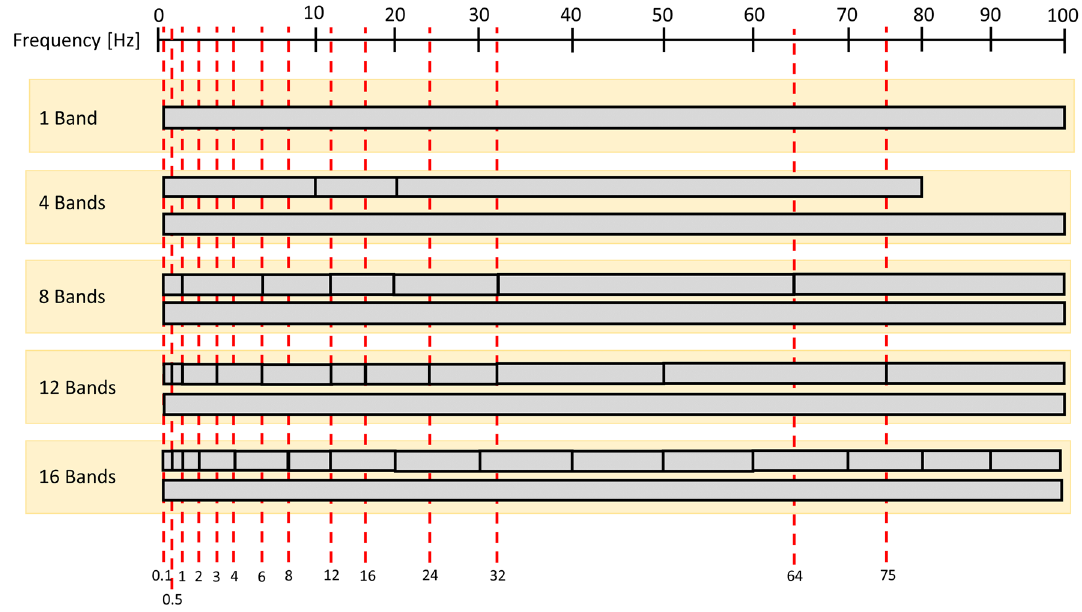
Figure 7. Considered frequency spectrum